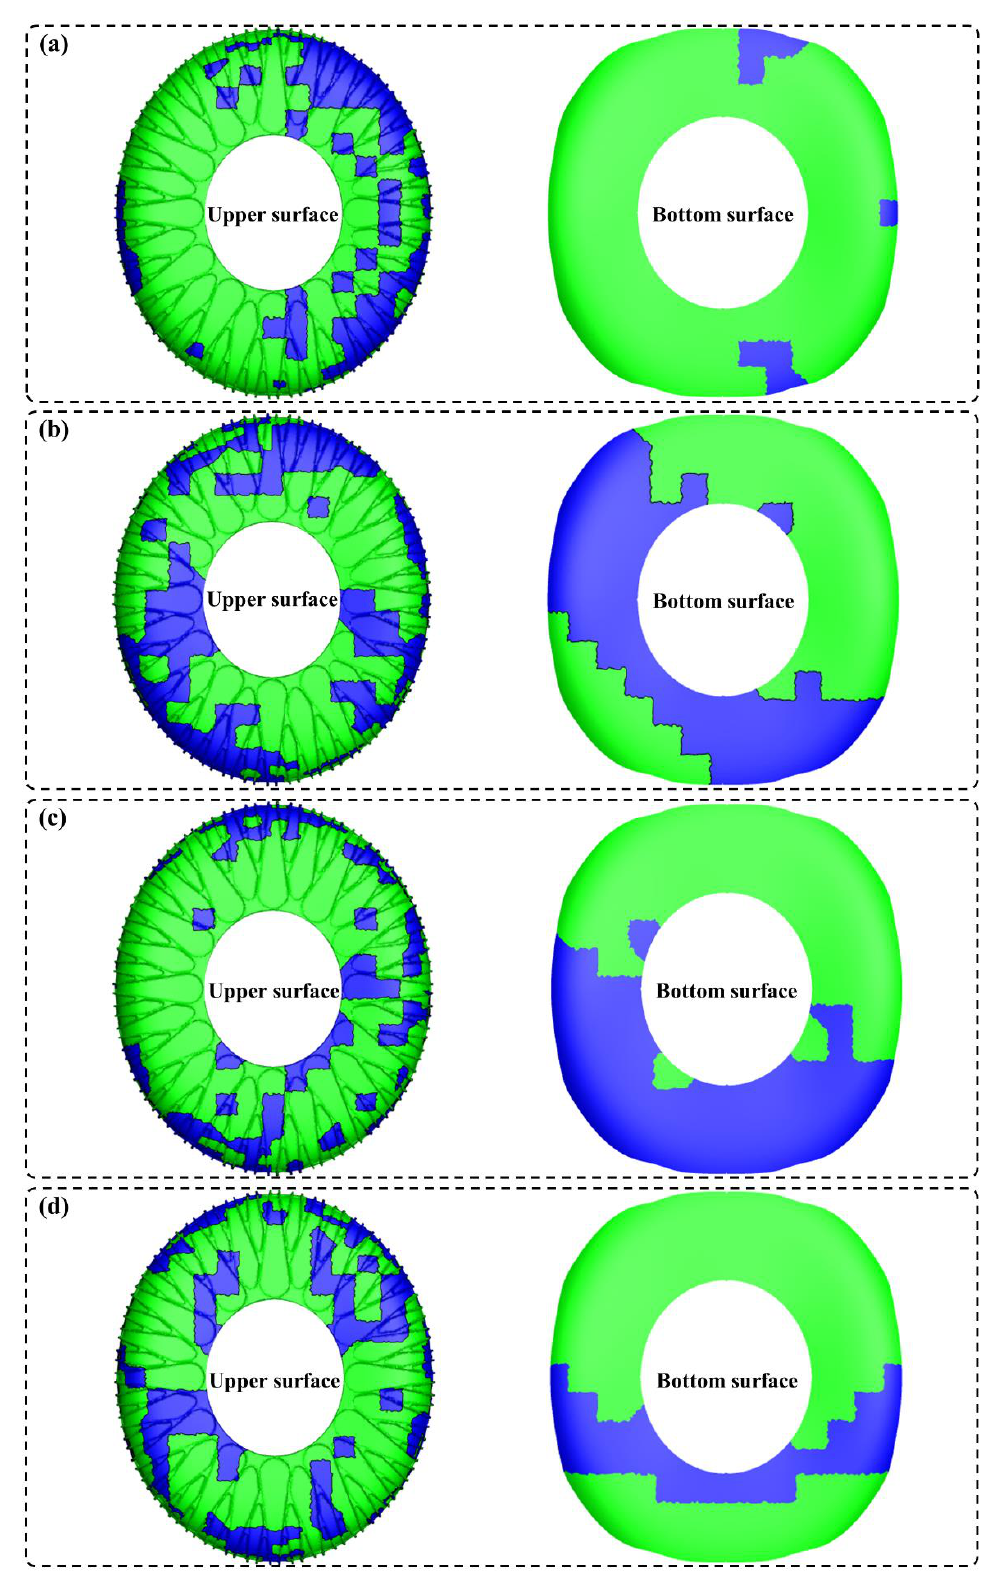
Figure 11. Division of Gaussian and non-Gaussian regions of the roof under different wind angles: ( a ) 0°; ( b ) 30°; ( c ) 60°; ( d ) 90°. The blue and green areas are Gaussian and non-Gaussian areas, respectively.